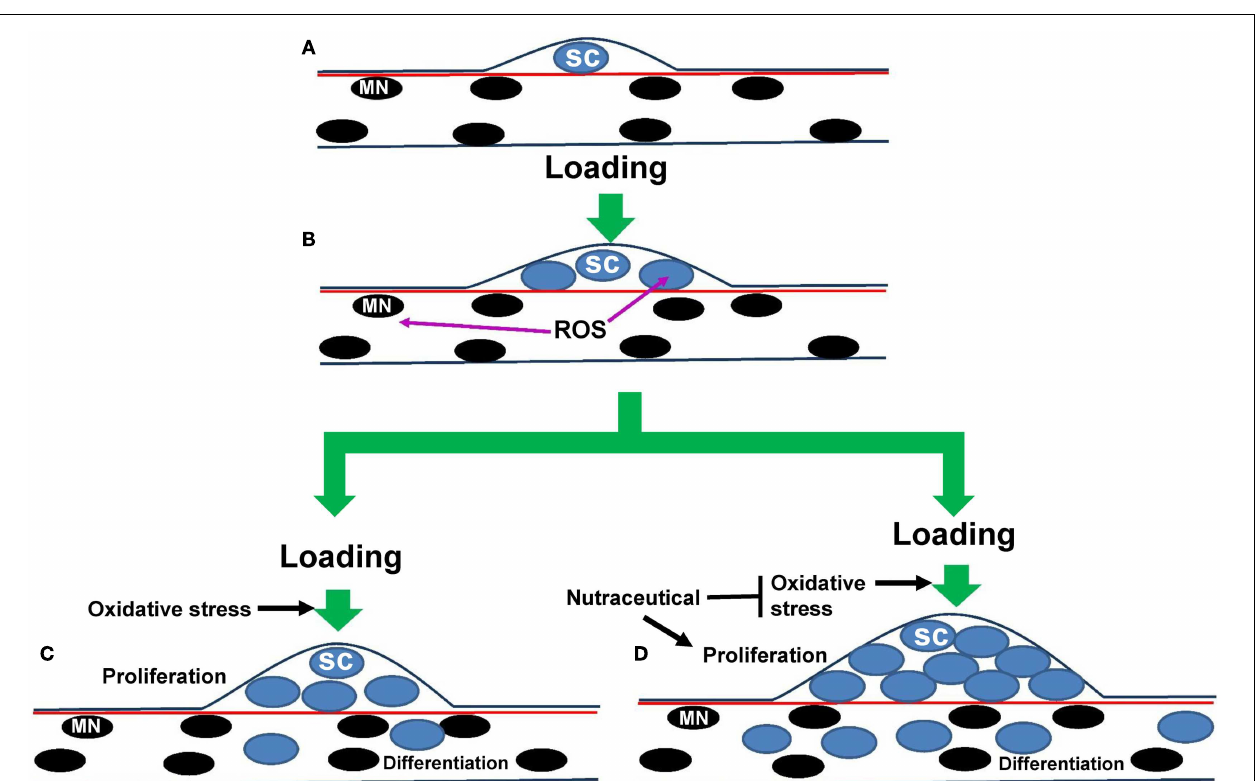
FIGURE 2 | Hypothetical model for nutraceutical effects on satellite cell proliferation in sarcopenia during muscle loading . (A) A muscle fiber is illustrated that shows myonuclei (black) and a single satellite cell (blue) that is positioned between the basal lamina (dark blue line) and the sarcolemma (red line). (B) Loading of aged muscles results in proliferation of the original satellite cell nuclei, but it also increases reactive oxygen species